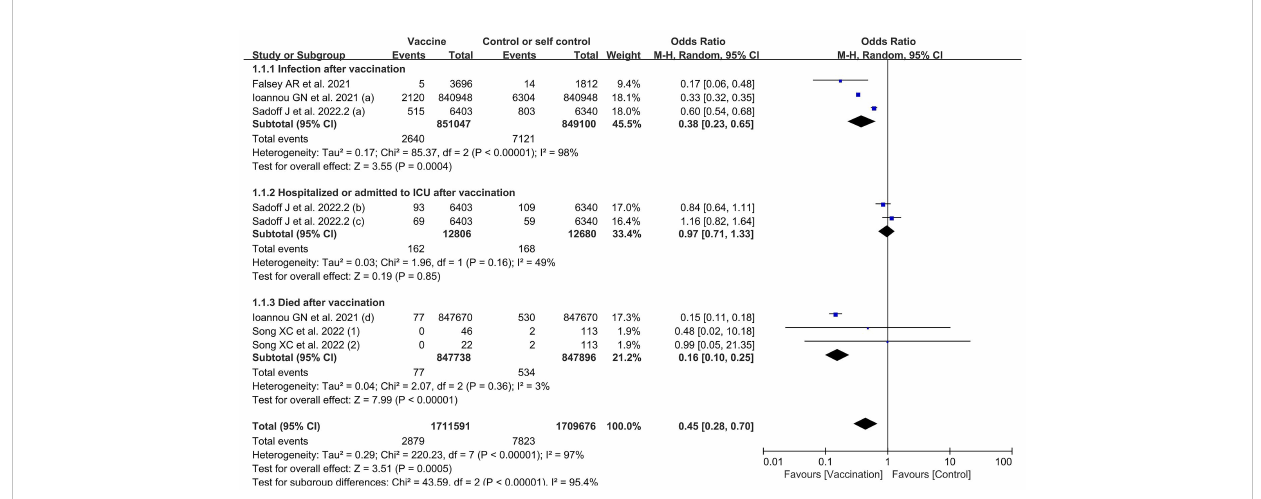
FIGURE 4 Forest plots of vaccine effectiveness by number of doses for the coronavirus disease 2019 (COVID-19) vaccine group compared with the control group. (a), infection after vaccination; (b), hospitalized after vaccination; (c), admitted to ICU after vaccination; (d), death after vaccination; 1 , one dose; 2 , two